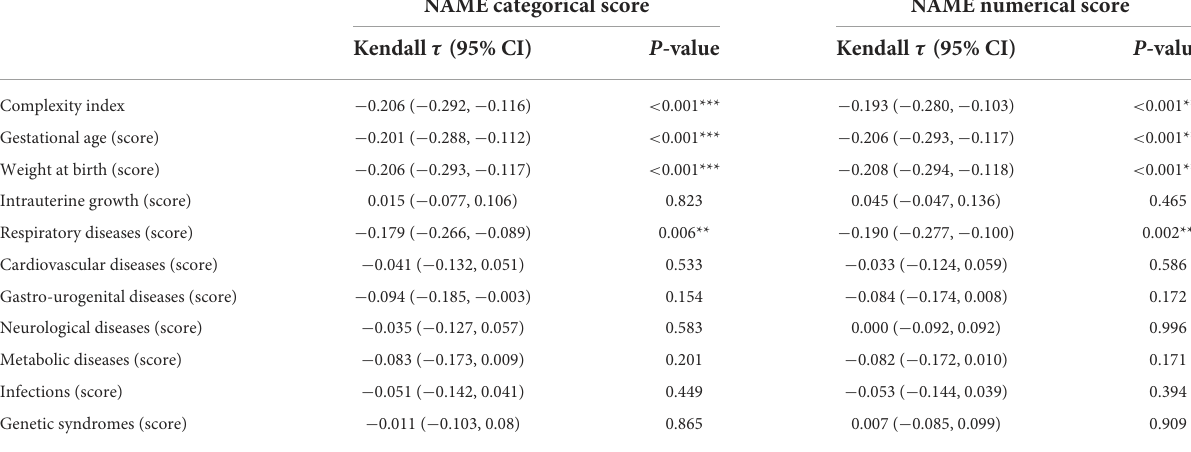
TABLE 6 Univariate statistical analyses between NAME scores and complexity index scores through Kendall tau correlation